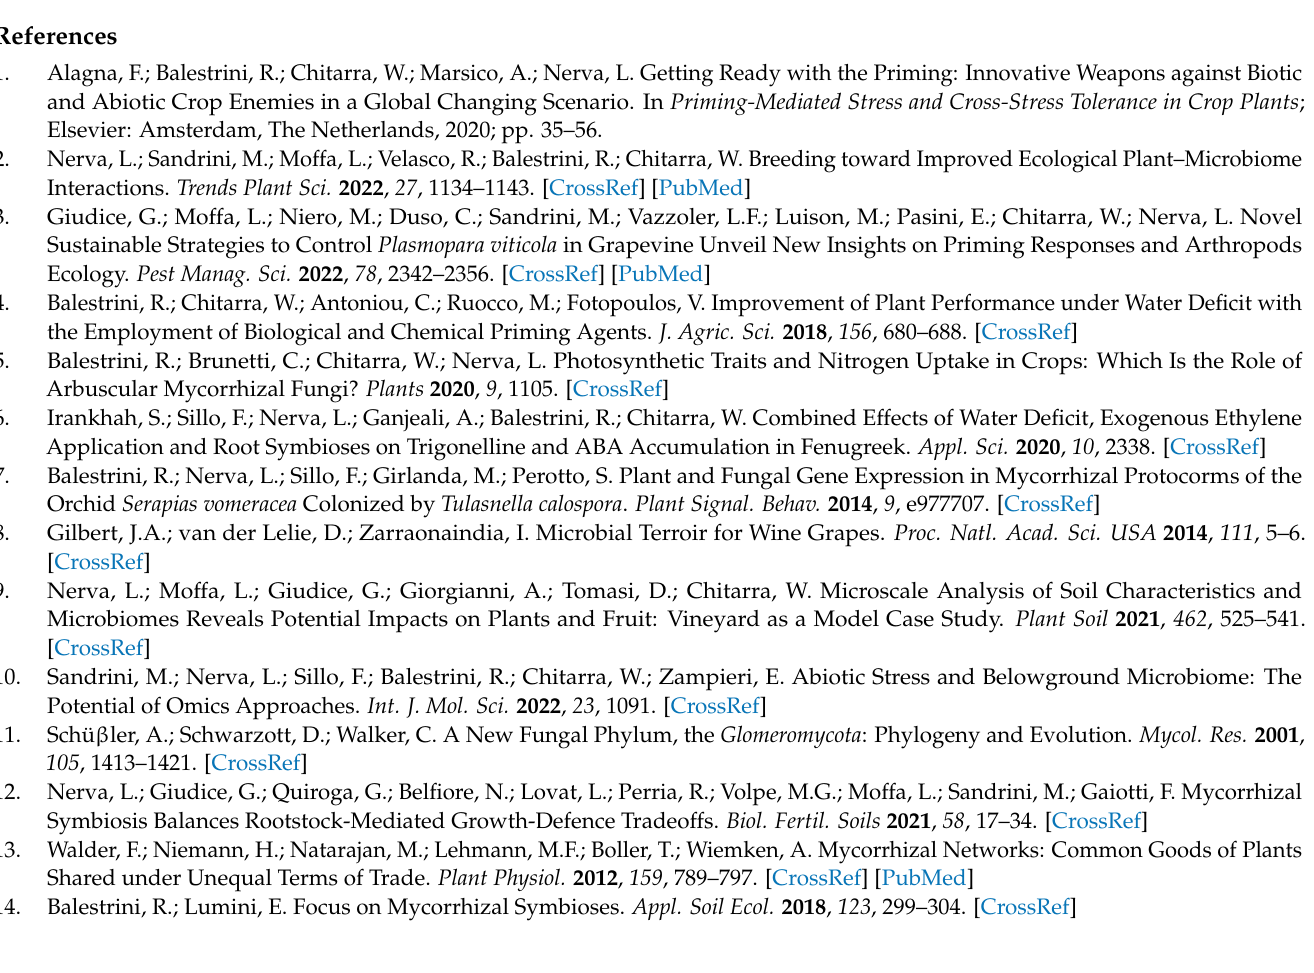
Figure S1: Climatic data recorded during the experimental trial (July 2020 and 2021). Average daily rainfall (blue dashed lines), average daily air temperature (mT, red lines) and average Vapor Pressure Deficit (mVPD, black lines) retrieved from the weather station during July 2020 and